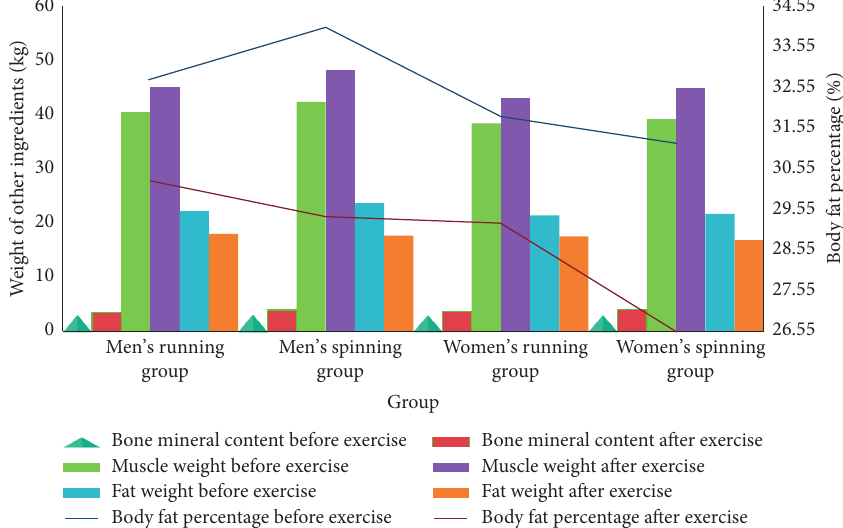
Figure 3: Changes in blood lipids in patients with dyslipidemia before and after